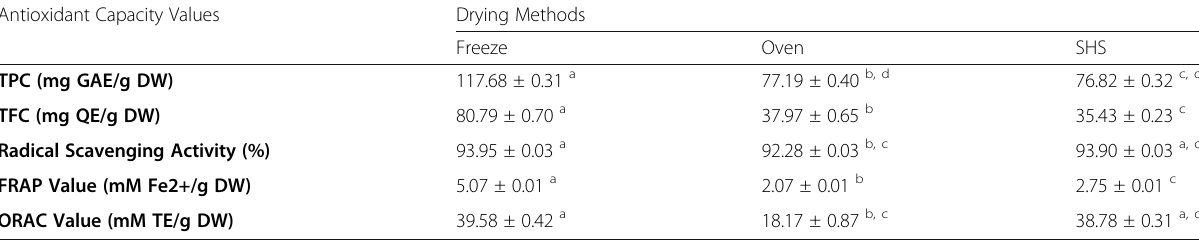
Table 1 TPC, TFC, and antioxidant capacity of tea [ Camellia sinensis (L.) Kuntze] leaves Antioxidant Capacity